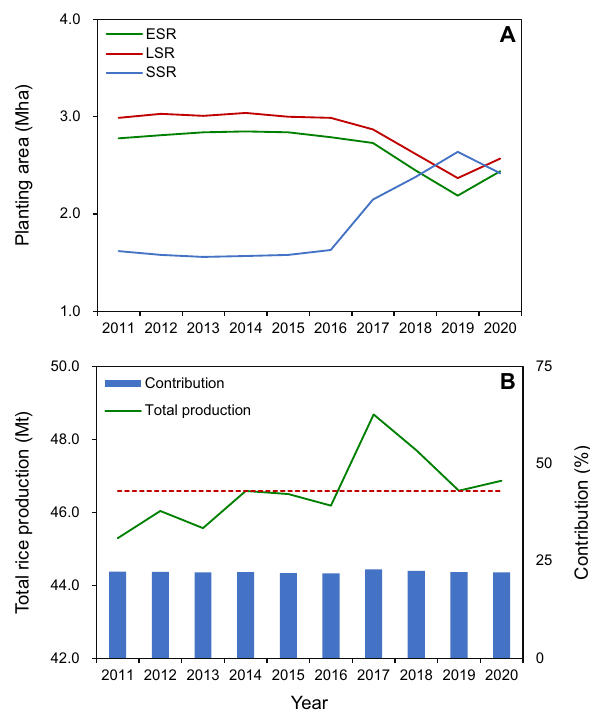
Figure 1. ( A ) Planting areas (million hectares, Mha) for early-season rice (ESR), late-season rice (LSR), and single-season rice (SSR) in the Hunan-Jiangxi region and ( B ) total rice production (million tons, Mt) in the Hunan-Jiangxi region and the contribution of the Hunan-Jiangxi region to total rice production in China from 2011 to 2020. In ( B ), the dashed line represents the average rice production during 2011–2020. The rice planting area and total rice production in the Hunan-Jiangxi region were calculated based on data collected from the Hunan Provincial Bureau of Statistics 8 and the Jiangxi Provincial Bureau of Statistics 9 . The contribution of the Hunan-Jiangxi region to rice production in China is the percentage of total rice production in the Hunan- Jiangxi region to the total rice production in China. Data for total rice production in China were collected from the National Bureau of Statistics of China 10